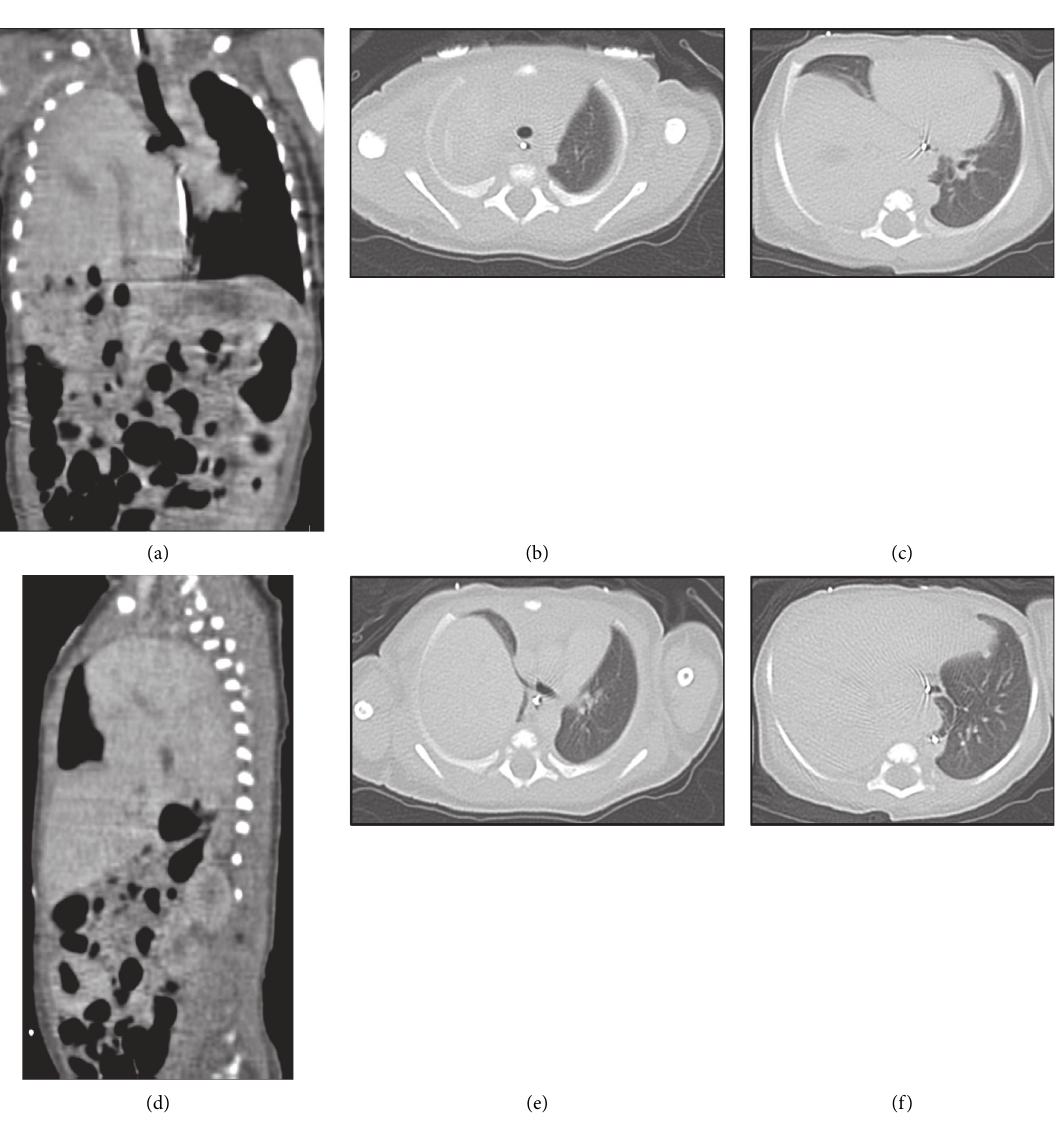
Figure 2: Computed tomography scans one day after birth. (a) Coronal view of the liver in the right hemithorax extending to the apex with leftward mediastinal shift. (b) Axial images depicting the apex of the lungs, with the right lung apex completely compressed by the liver. (c) Axial view showing the leftward mediastinal shift and the extent of aeration of the right middle lobe. (d) Sagittal view of right lung at the level of greatest aeration. (e) Axial view depicting the right mainstem bronchus and cardiothymic shift. (f) Axial view suggesting possible aplasia of the right lower